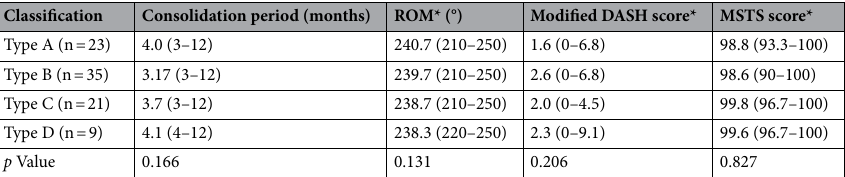
Table 1. Radiological and clinical outcomes according to Takigawa classification. ROM range of motion of the finger; DASH Disabilities of the Arm, Shoulder, and Hand; MSTS Musculoskeletal Tumor Society. *Assessments were performed at postoperative 6 months.